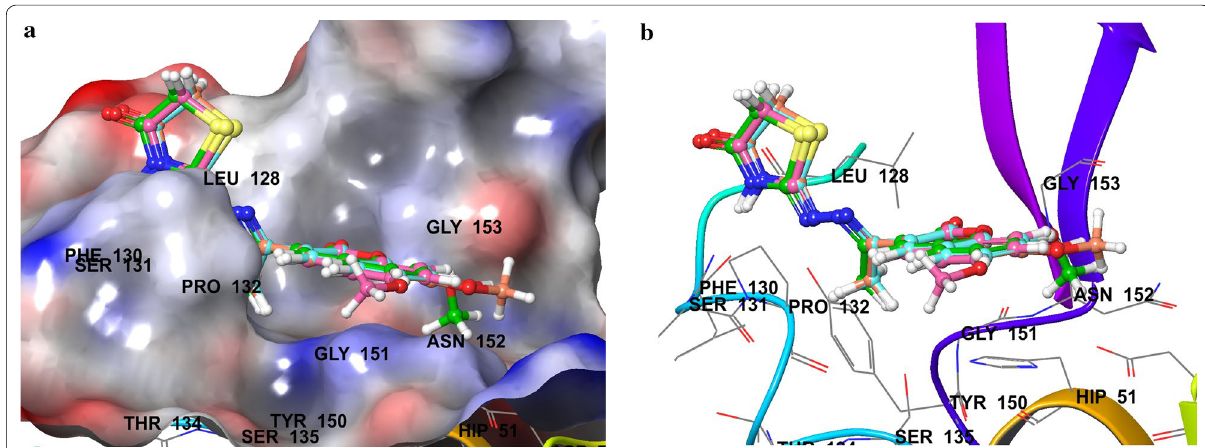
Fig. 10 Binding modes of compounds SKYf , SKYd , SKYc and SKYe with dengue virus NS2B/NS3 protease: a Protein as surface and compounds as sticks; b Protein as ribbon and compound as